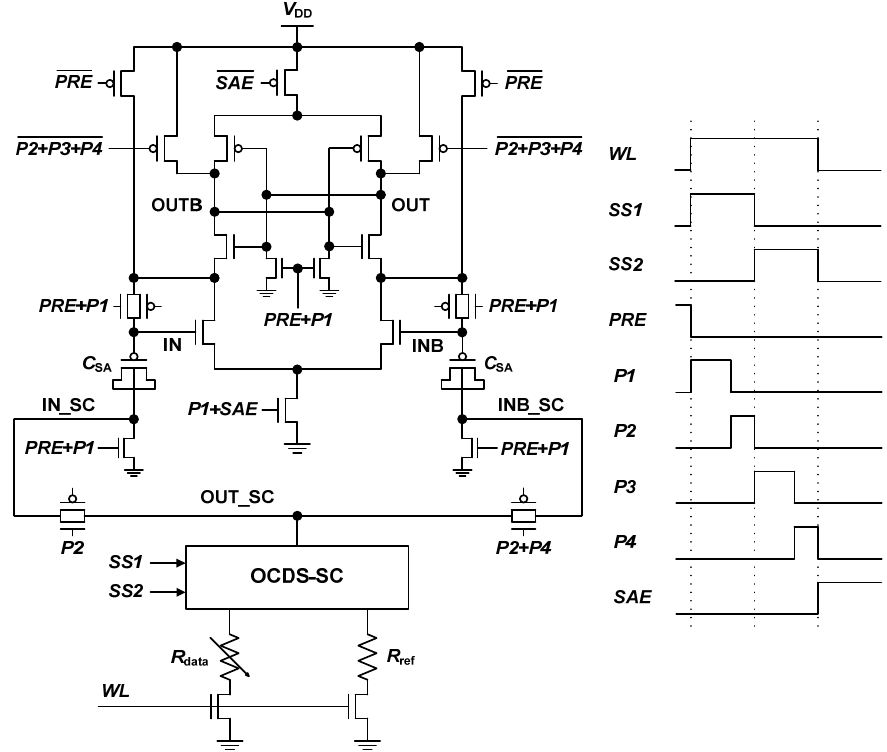
Figure 5. Schematic and timing diagrams of the proposed offset-canceling zero-sensing-dead-zone SA (OCZS-SA).